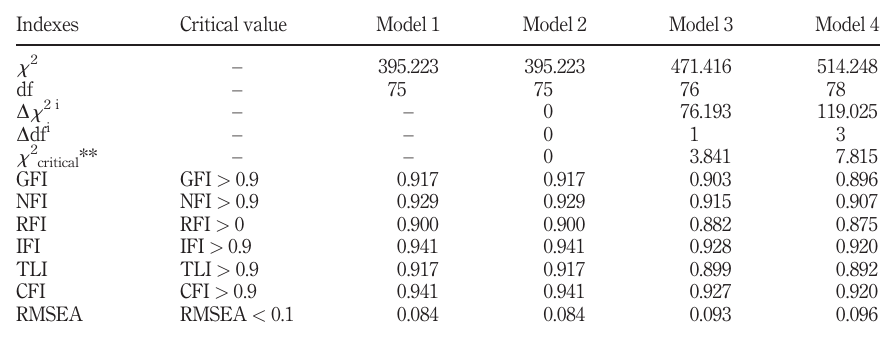
Figure 3. Theoretical and alternative structural models